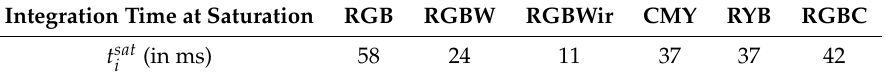
Table 7. Integration time when the most sensitive channel starts to saturate. Integration Time at